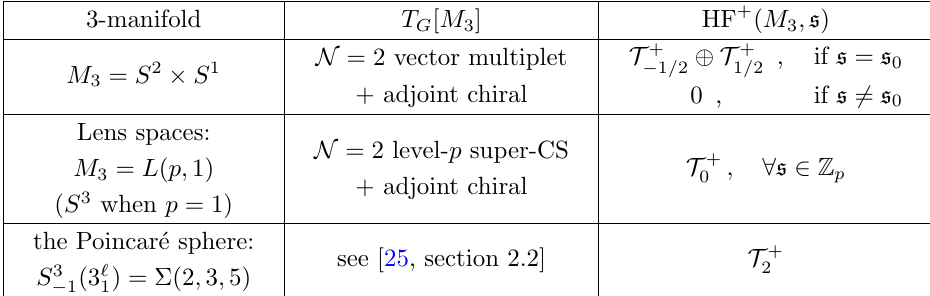
Table 1 . Simple examples. In the last column we use the standard notation T + for the module over k the ring Z [ U ] abstractly isomorphic to Z [ U; U (cid:0) 1 ] = Z [ U ], whose lowest degree element is supported (cid:0) (cid:1) in degree k 2 Q [26]. Note, HF + (cid:6)(2 ; 3 ; 5) is isomorphic to HF + ( S 3 ) as relatively graded Z [ U ] modules, but the absolute grading distinguishes